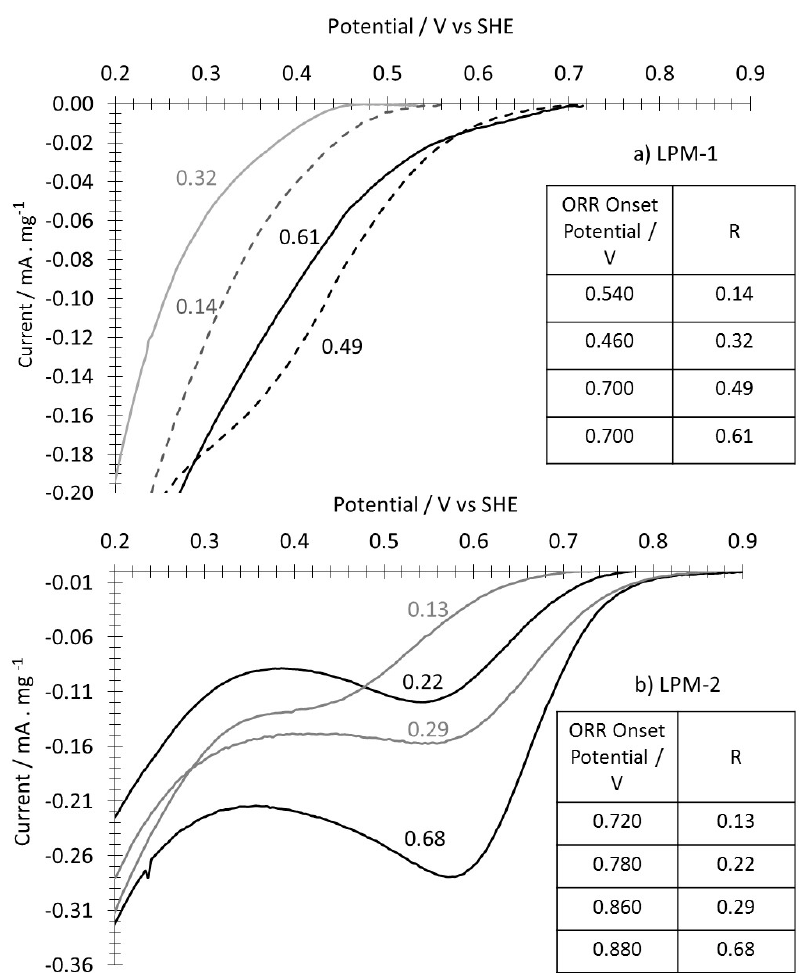
Figure 12. Cyclic voltammetry recorded on porous electrodes prepared from materials synthesized with LMP-1 ( a ) and LPM-2 ( b ) in HClO 4 1 M at 5 mV·s − 1 . The inserted tables report the R values and the corresponding onset potentials for the ORR.